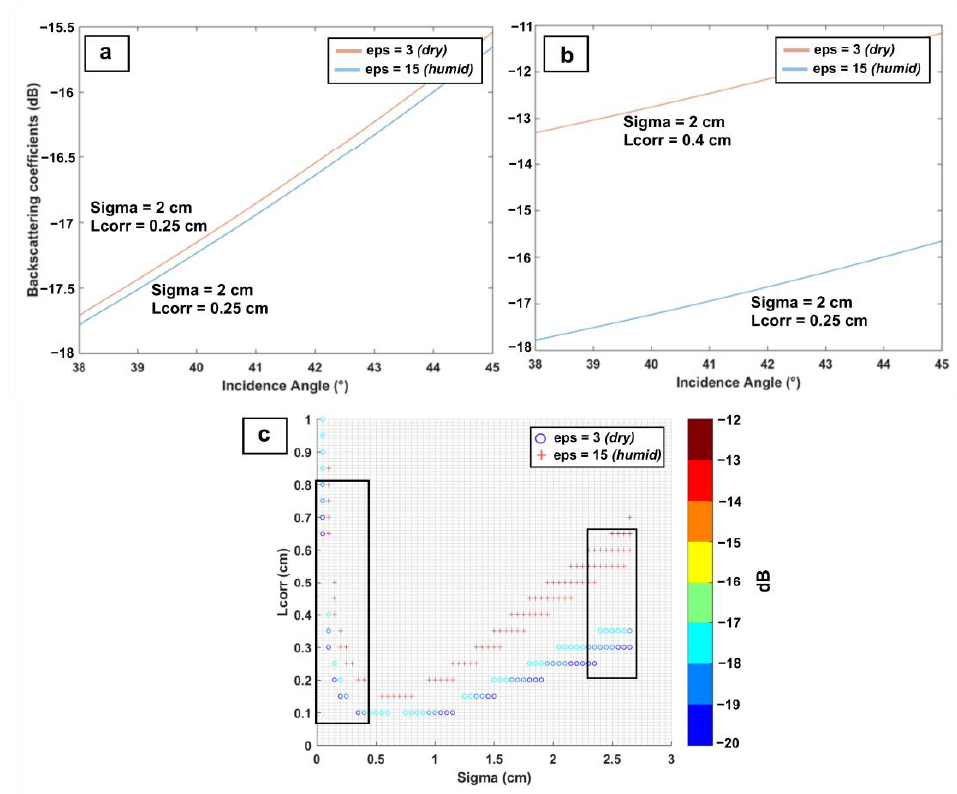
Figure 6. Surface backscattering model outputs with ( a ) fixed σ, Lcorr in dry/humid conditions; ( b ) different σ, L corr in dry/humid conditions; and ( c ) σ, L corr values in the black boxes allow us to reproduce σ 0 variations observed in the Sentinel-1 time-series from the lower Kuiseb River.